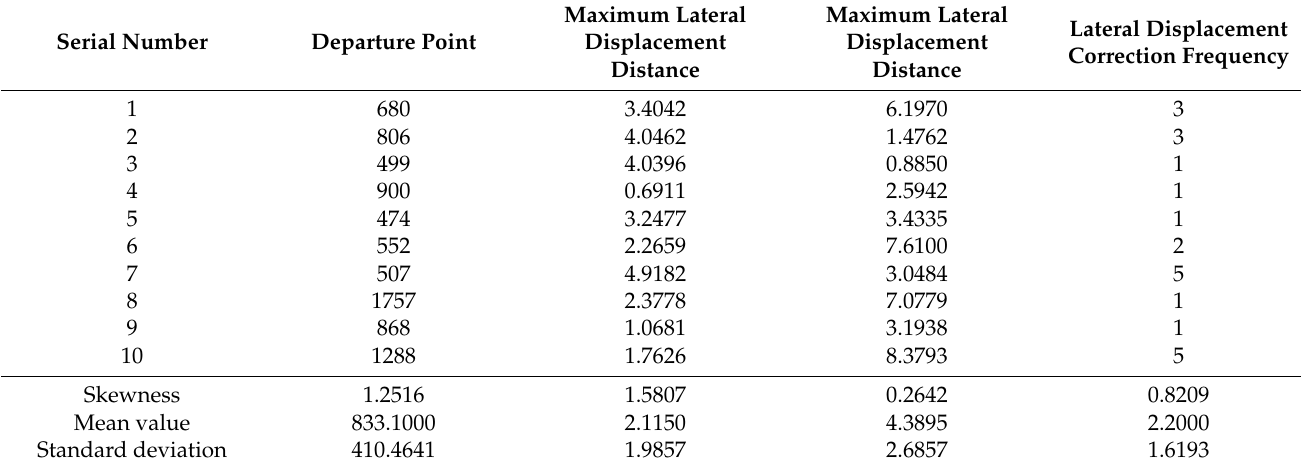
Table 16. P1 take-off simulation data in round